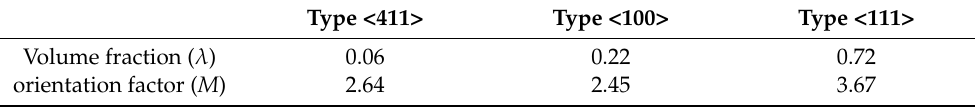
Table 1. Volume fractions and orientation factors for three different grain orientations.